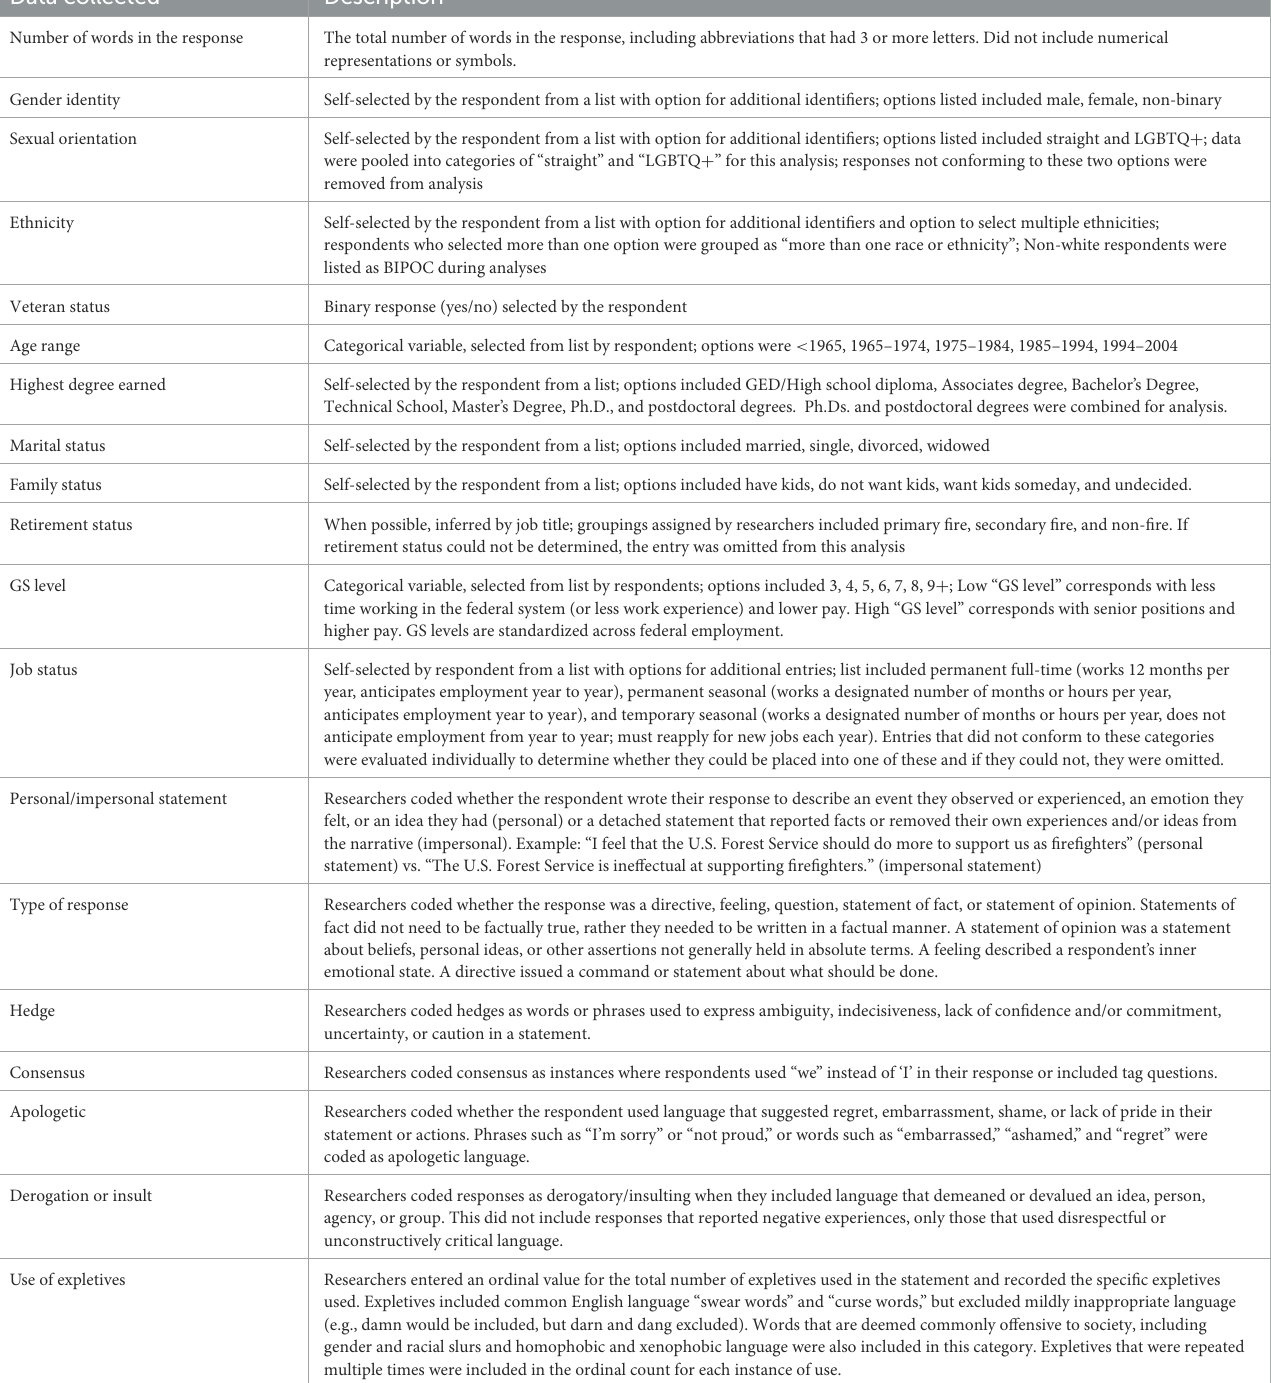
TABLE 2 Comment attributes analyzed in this study and descriptions of how the attribute was defined by the